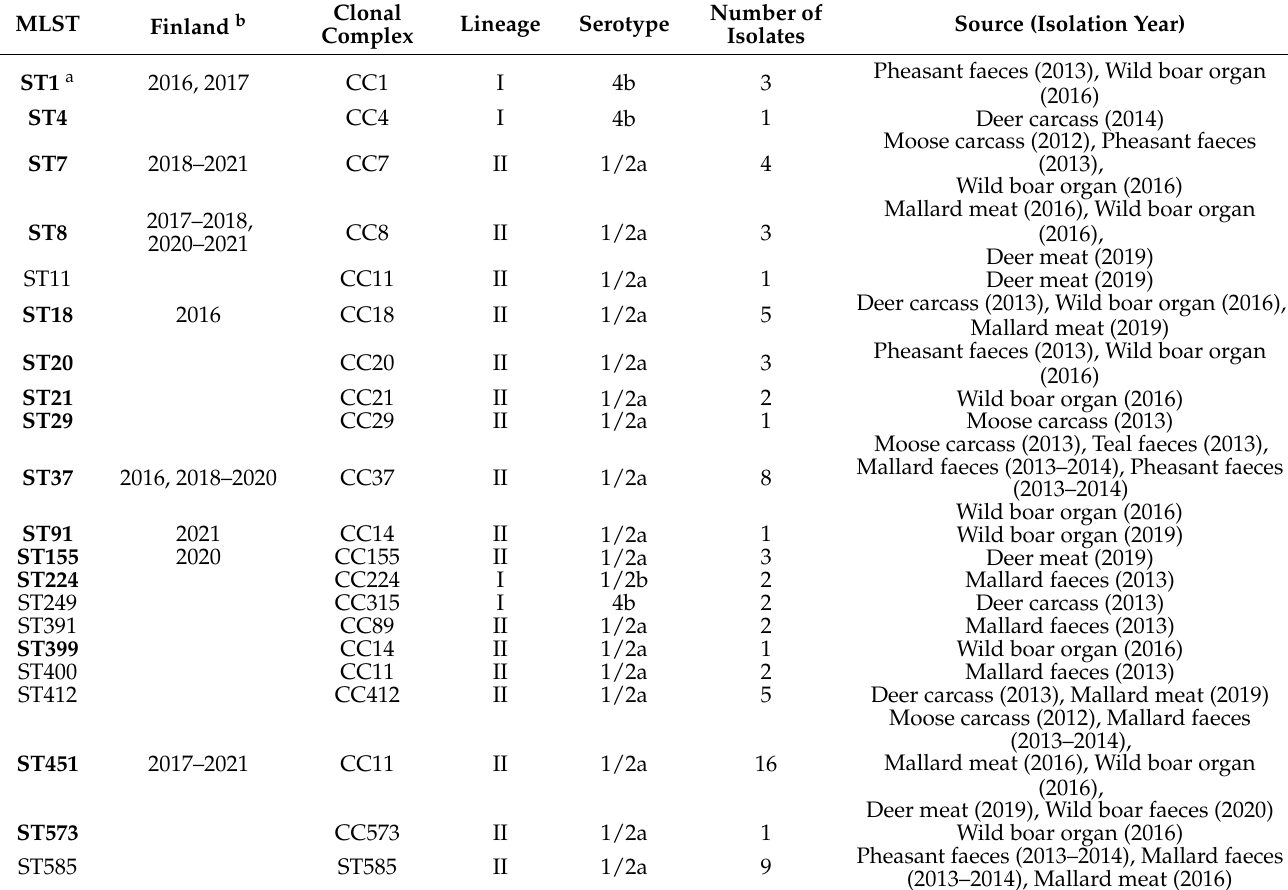
Table 3. Characteristics of 75 Listeria monocytogenes isolates from hunted game and game meat from Finland between 2012 and